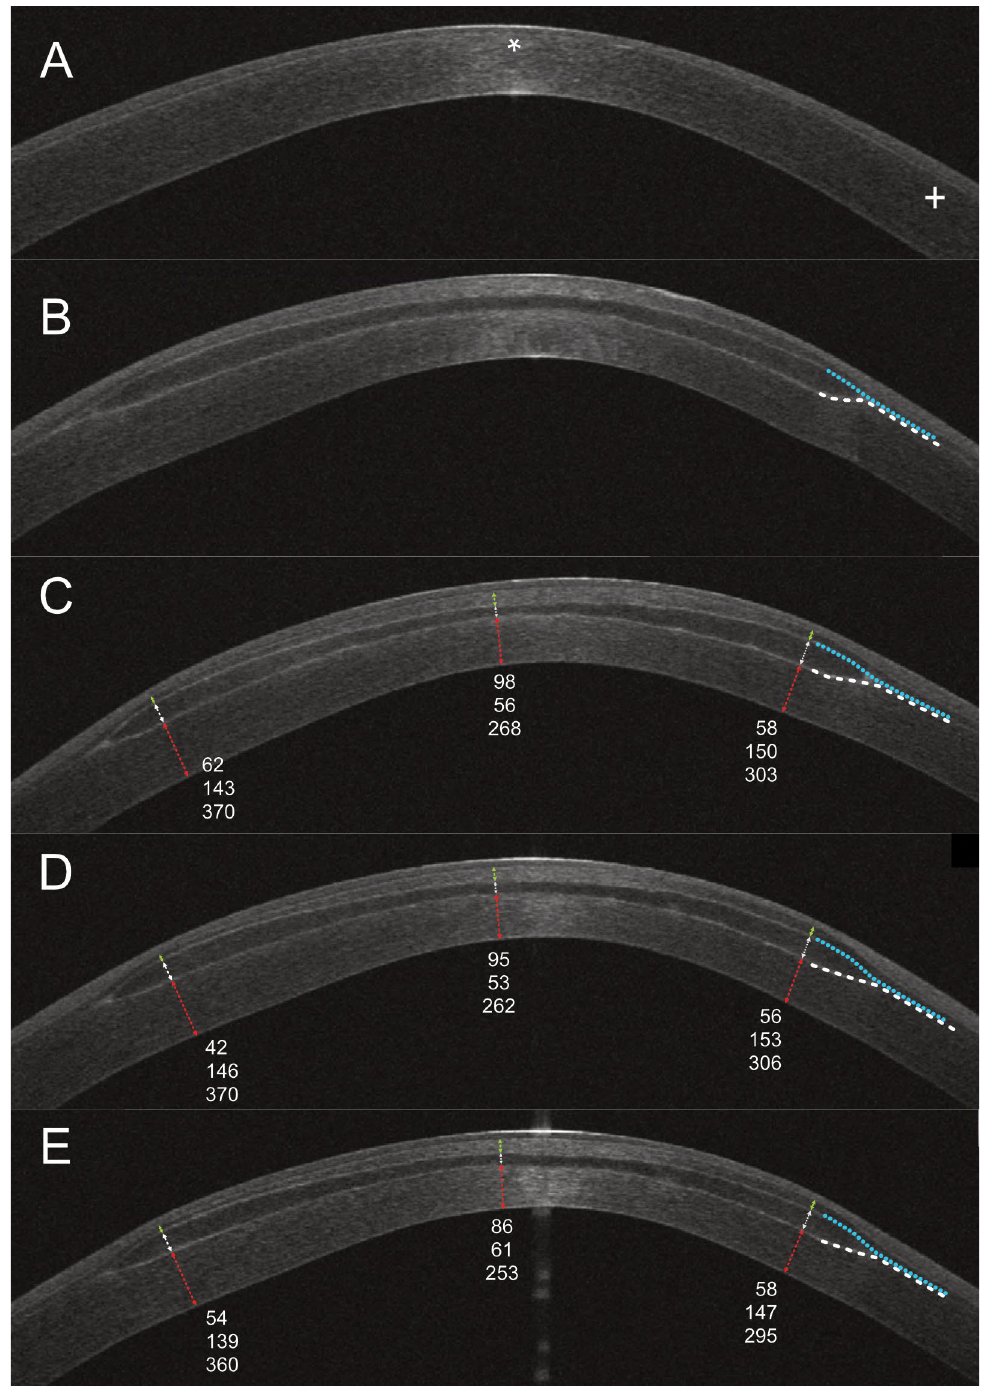
Figure 4. Preoperative AS-OCT horizontal scan of the central cornea ( A ) showed normo-reflective thinned stroma and reduced epithelial thickness in correspondence with the cone apex (white asterisk). 1 week after SLAK ( B ) the implanted lenticule appeared hypo-reflective in the central region with respect to the surrounding stroma and bordered by hyper-reflective interfaces. Anterior (green line), lenticule (white line) and posterior (red line) stromal thickness were measured in the center and at 3-mm radius. Measured thicknesses in microns are reported in the corresponding positions. Lenticule stroma remained hypo-reflective throughout the follow-up while lenticule wedge-shaped borders that were distorted by the transient tissue oedema at 1 week, regularized in shape over time with smoothening of transition zones of the lenticule, as marked by the dashed lines ( C : 1 month, D : 3 months, E : 6